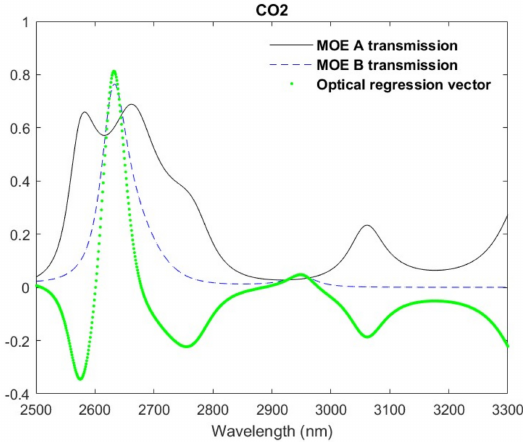
Figure 4. Dual-core transmission profiles for CO 2 .